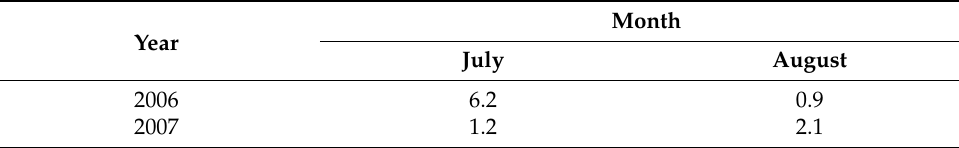
Table 5. Values of the Stenz index for the 2006–2007 irrigation period.